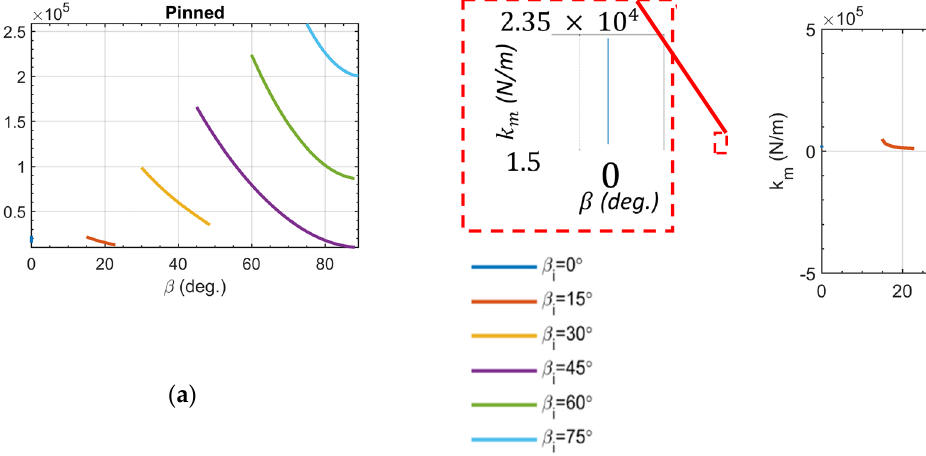
Figure 15. Variation muscle stiffness behavior of parallel ( β i = 0 ◦ ) and bipennate muscle bundles with pinned boundary condition ( a ) and fiber contact boundary condition ( b ). The legend shown on the far right indicates the fiber pennation angle of the muscle topology. The inset plot shown in the red dashed box illustrates the muscle stiffness range for a parallel muscle bundle. The muscle stiffness range for the parallel topology is the same for both boundary conditions.